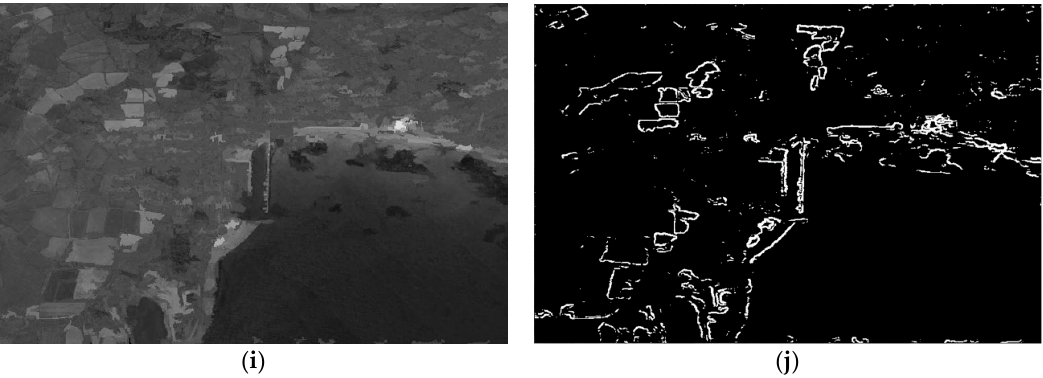
Figure 2. ( a ) The original image. ( b ) The edge detection result of original image by Prewitt. ( c ) The smoothing result by the bilateral filtering algorithm. ( d ) The edge detection result of Figure 2c by Prewitt. ( e ) The smoothing result by the general edge-preserve algorithm. ( f ) The edge detection result of Figure 2e by Prewitt. ( g ) The smoothing result by the guided filtering algorithm. ( h ) The edge detection result of Figure 2g by Prewitt. ( i ) The smoothing result by the method proposed. ( j ) The edge detection result of Figure 2i by Prewitt.